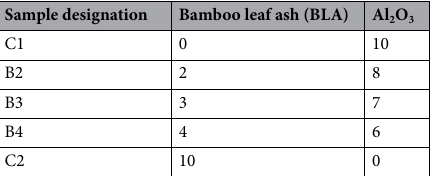
Table 2. Sample designation and weight ratio of the